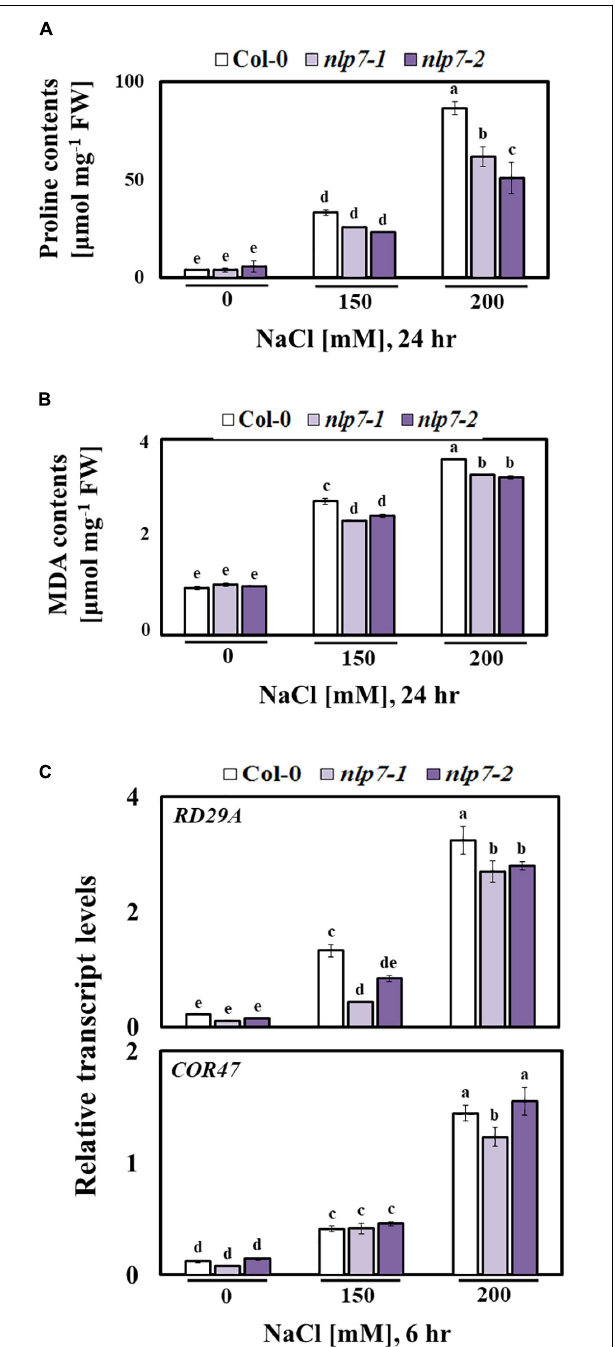
FIGURE 8 | The nlp7 mutants showed reduced proline and malondialdehyde (MDA) content and decreased relative transcript levels of stress marker genes. (A, B) Proline and MDA content of 9-day-old Col-0 and nlp7 seedlings germinated and grown on a nitrogen-free half-strength MS medium containing 5 mM KNO 3 and then treated with 0, 150, or 200 mM NaCl for 24 h. Error bars represent the standard deviation of three independent replicates. (C) Relative transcript levels of RD29A and COR47 (stress marker genes) in 9-day-old Col-0, nlp7-1 , and nlp7-2 seedlings in response to salt stress,as determinedusingqPCR.The seedsweregerminated andgrownona